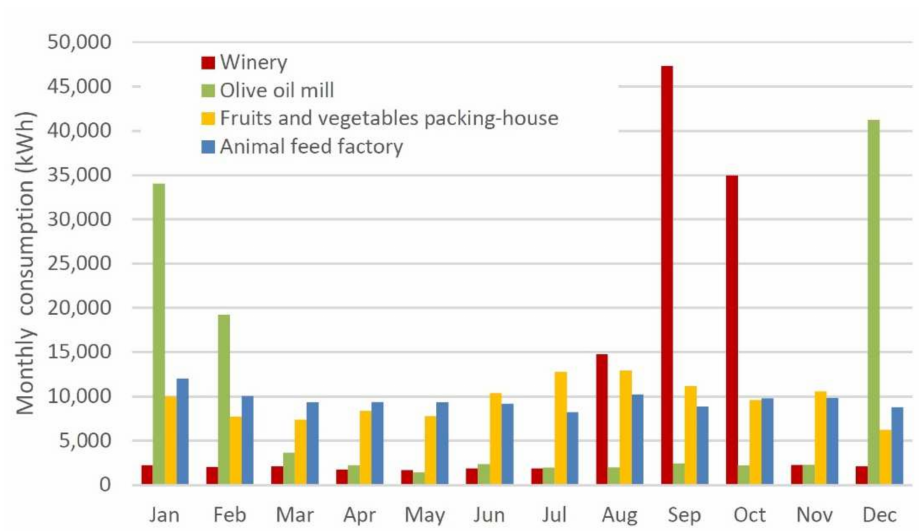
Figure 3. Evolution of the monthly energy consumption of each of the industries analysed.